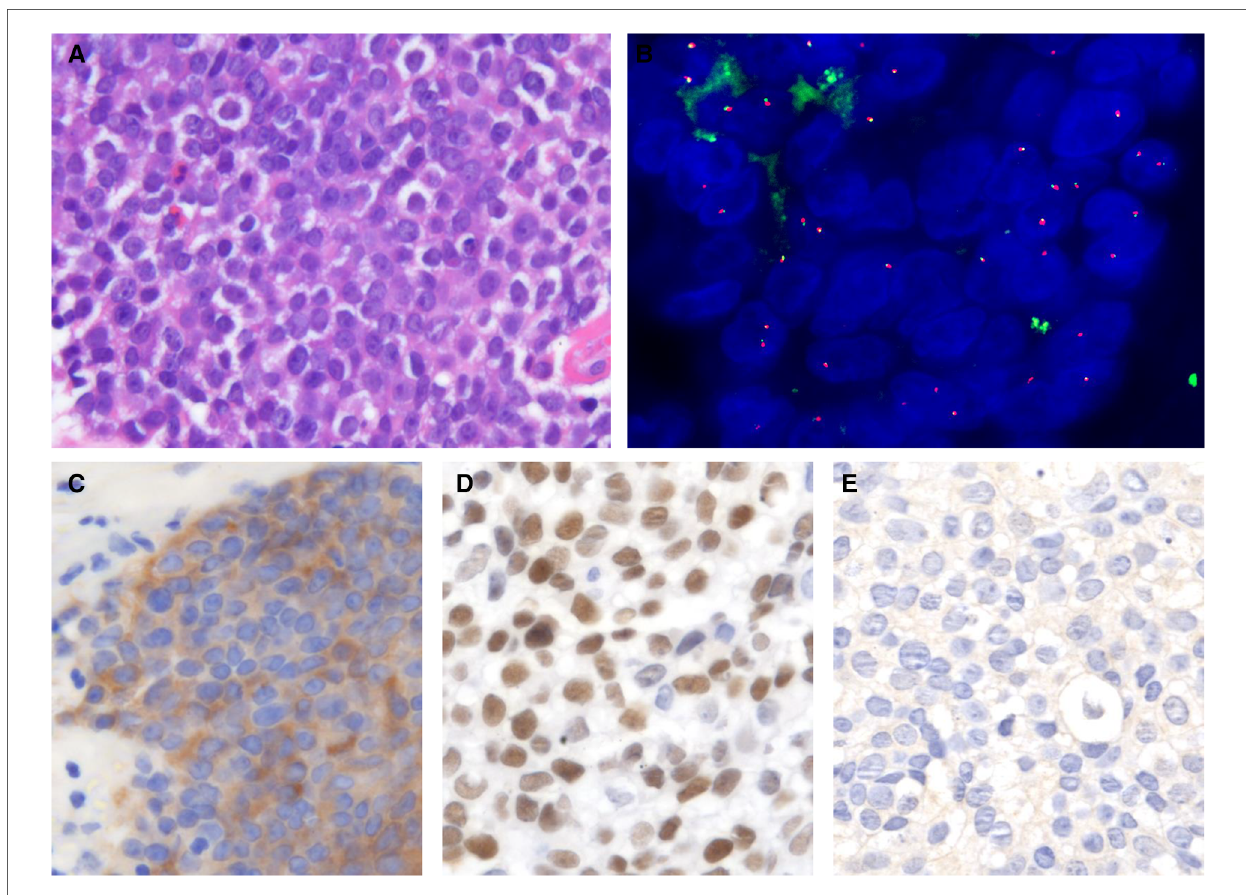
FIGURE 4 Histological and IHC features of the case with weakly NUT positive. ( A ) Tumor cell nuclei were large and round. ( B ) FISH assay was negative. ( C ) NUT positivity was seen in the cytoplasm but not the nucleus. ( D ) Diffuse p63 positivity is present. ( E ) Negative staining for PD-L1 (HE and IHC, original magni fi cation